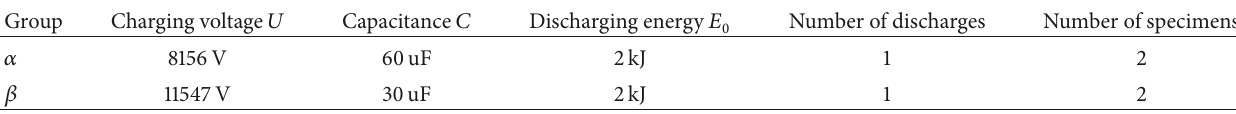
Table 1: High voltage pulsed discharge parameters